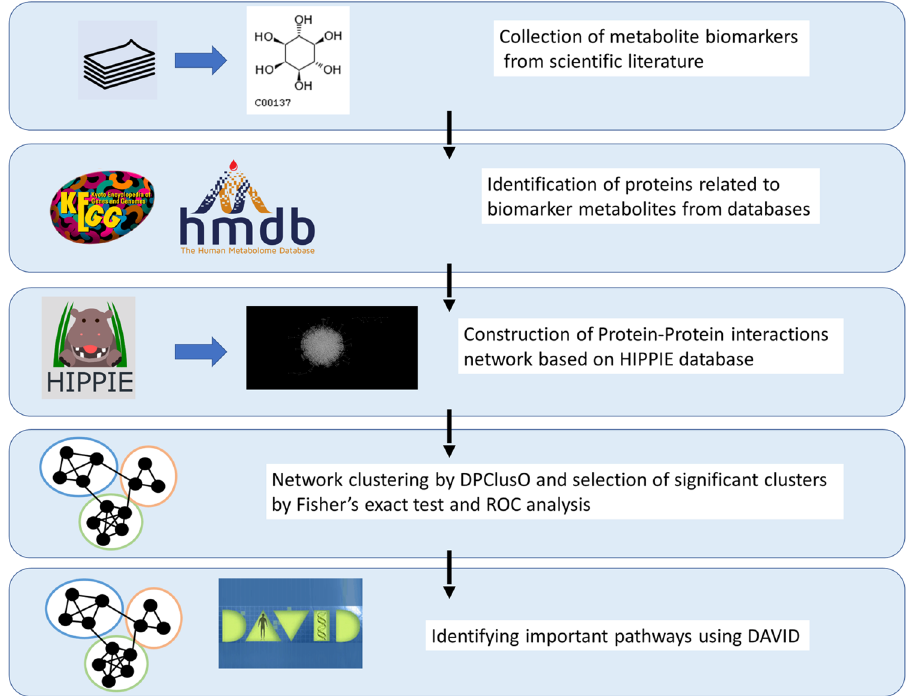
Figure 1. Flowchart showing each steps of the present research . The flowchart shows the analysis performed in the present work, starting from fishing out the most relevant metabolite biomarkers from online databases, such as MEDLINE/PubMed (maintained by The United States National Library of Medicine at the National Institutes of Health). Then, the analysis was performed using Kyoto encyclopedia of genes and genomes (KEGG), human metabolome database (HMDB), Human integrated protein–protein interaction rEference (HIPPIE), DAVID (The database for annotation, visualization and integrated discovery) and a network clustering algorithm (DPClusO).